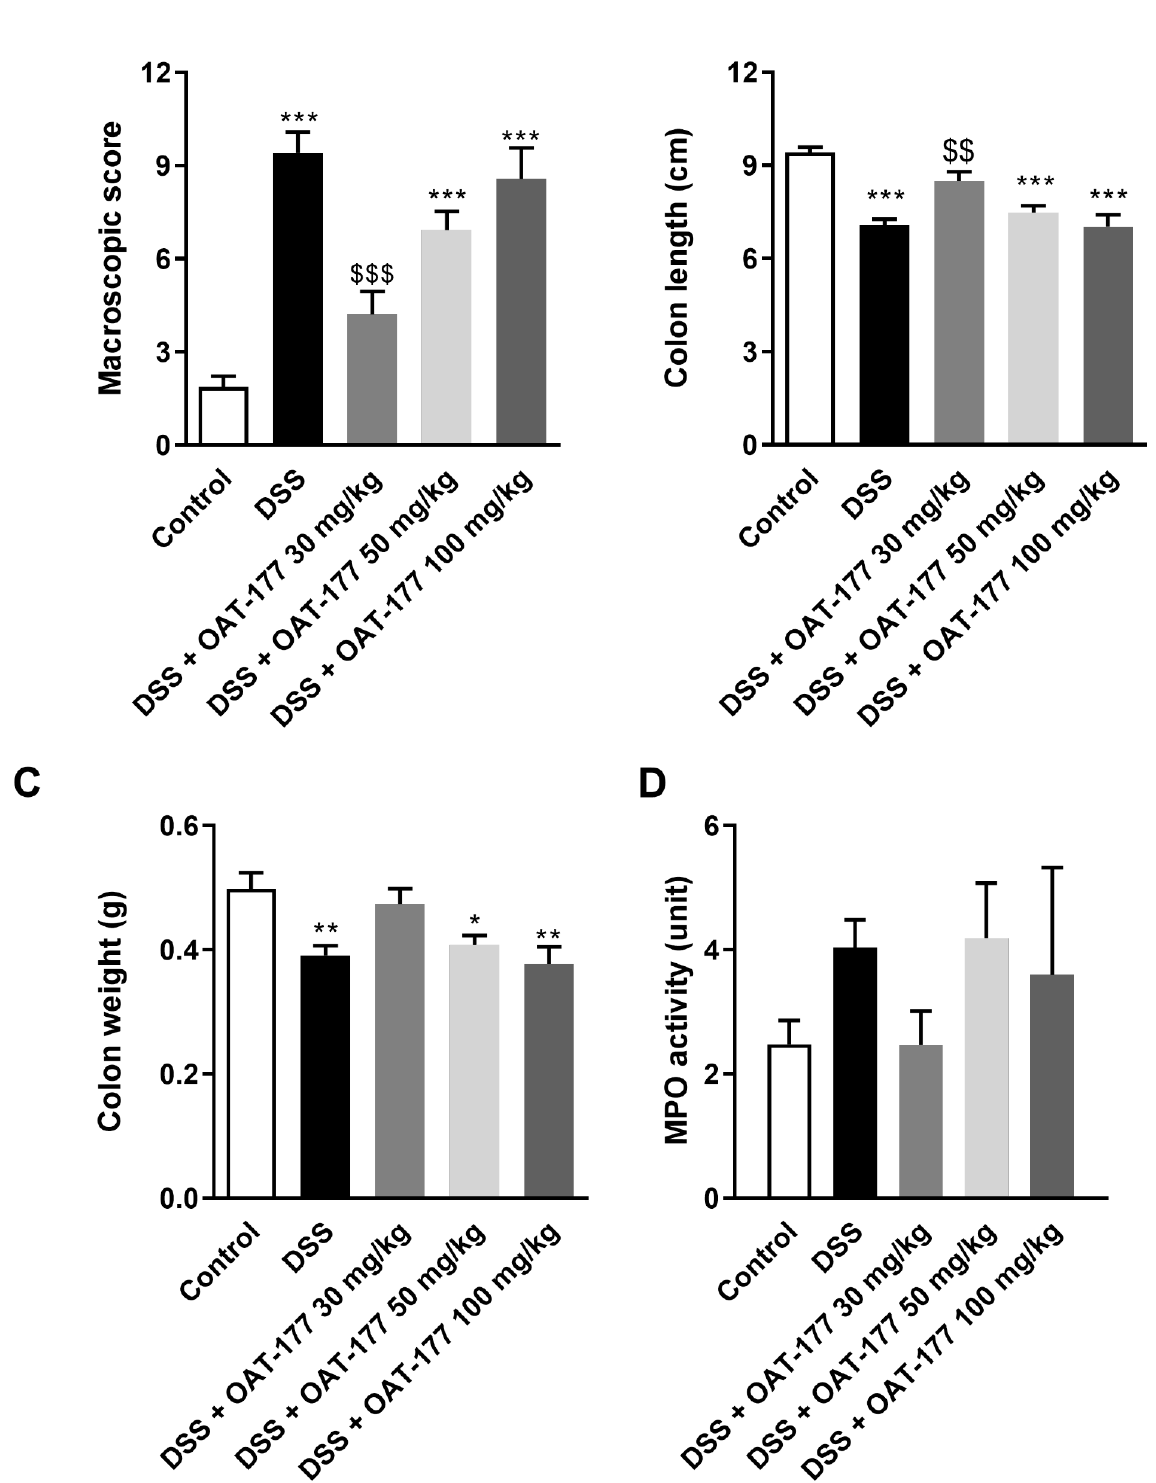
Figure 1. The effect of OAT-177 administered intragastrically in the short-term therapeutic protocol on: ( A ) macroscopic score, ( B ) colon length, ( C ) colon weight, and ( D ) myeloperoxidase (MPO) activity in a dextran sulfate sodium (DSS)-induced colitis. Data are expressed as mean ± SEM. Statistical significance from the one-way ANOVA, Tukey’s post hoc test: *** p < 0.001, ** p < 0.01, * p < 0.05 vs. control group; and $$$ p < 0.001, $$ p < 0.01 vs. DSS-only treated